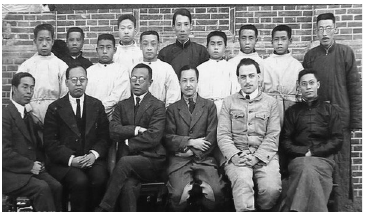
Figure 2. Dr. Wu Lien Teh (The 3rd from left, line 1) in The International Plague Conference (1911, in China).